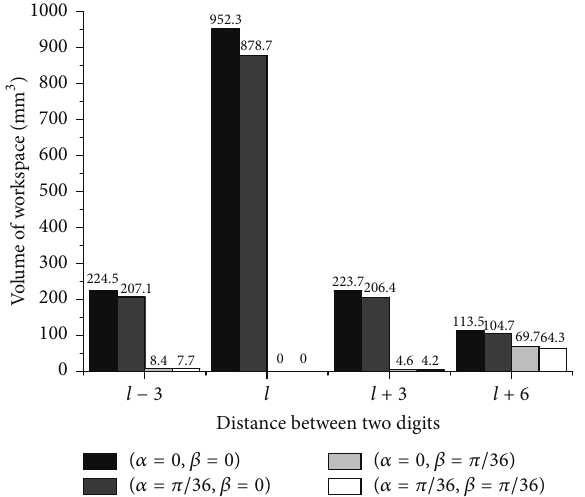
Figure 7: The volume of workspace versus the distance between two digits at four different orientations of the moving